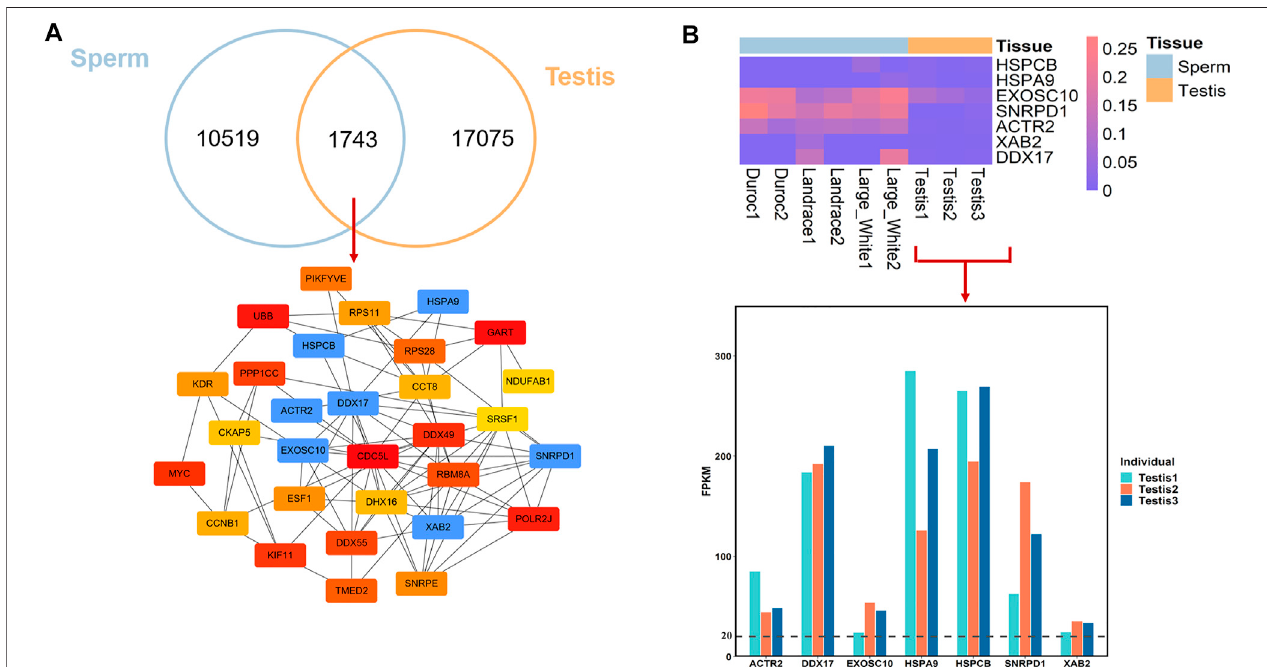
FIGURE 4 | DNA methylation conservation and divergences between sperm and testis in pig. (A) Overlap of HMRs and hub genes identi fi cation. (B) DNA methylation level in promoter regions between sperm and testis and gene expression of hub genes in testis.